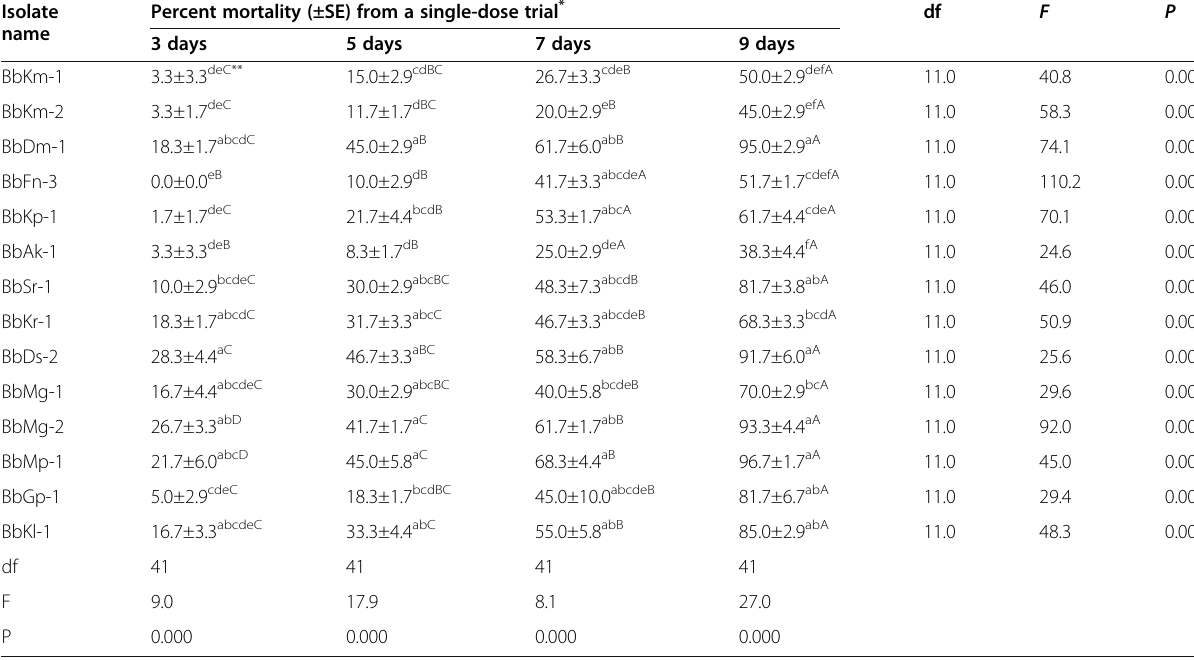
Table 4 Percentage mortalities of old larvae (3rd and 4th instars) of Leptinotarsa decemlineata in response to the tested Beauveria bassiana isolates at 3, 5, 7, and 9 days after treatment under laboratory conditions